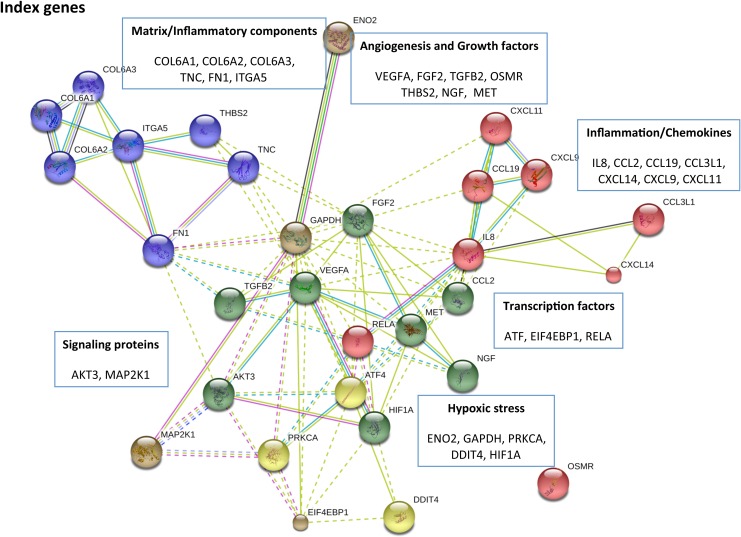
Index genes representing the major roles of the immature articular cartilage.The STRING10 network diagram indicates the functional clustering of the index genes. The nodes indicate individual genes and the connecting lines indicate the relationship. Shorter lines connect the closely related genes. Multiple connectors indicate stronger evidence for the functional relationship.